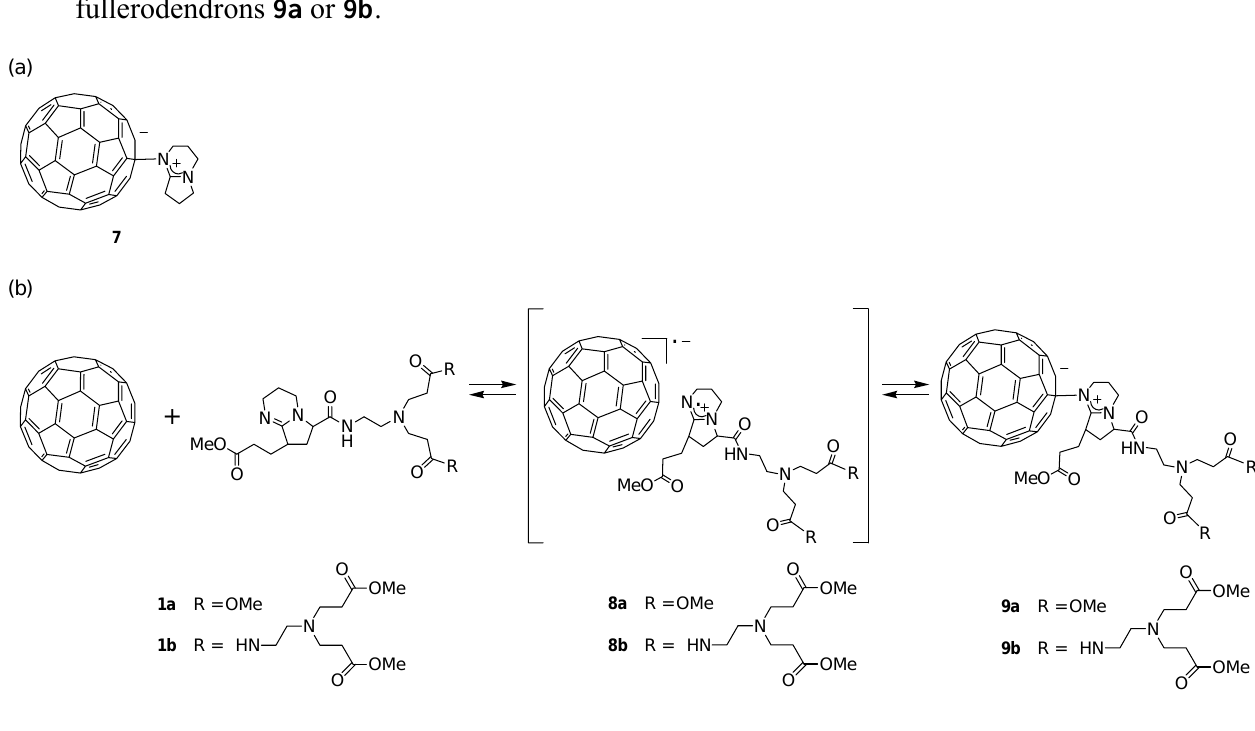
Figure 2. Vis-NIR spectra of the zwitterion 9b and radical ion pair 8b in benzonitrile. Inset: Vis-NIR spectrum of zwitterion 7